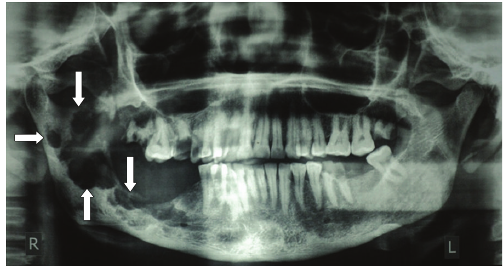
Figure 1: Orthopantamograph showing radiolucent area with irregular borders with no evidence of calcification or ossifications (arrows).